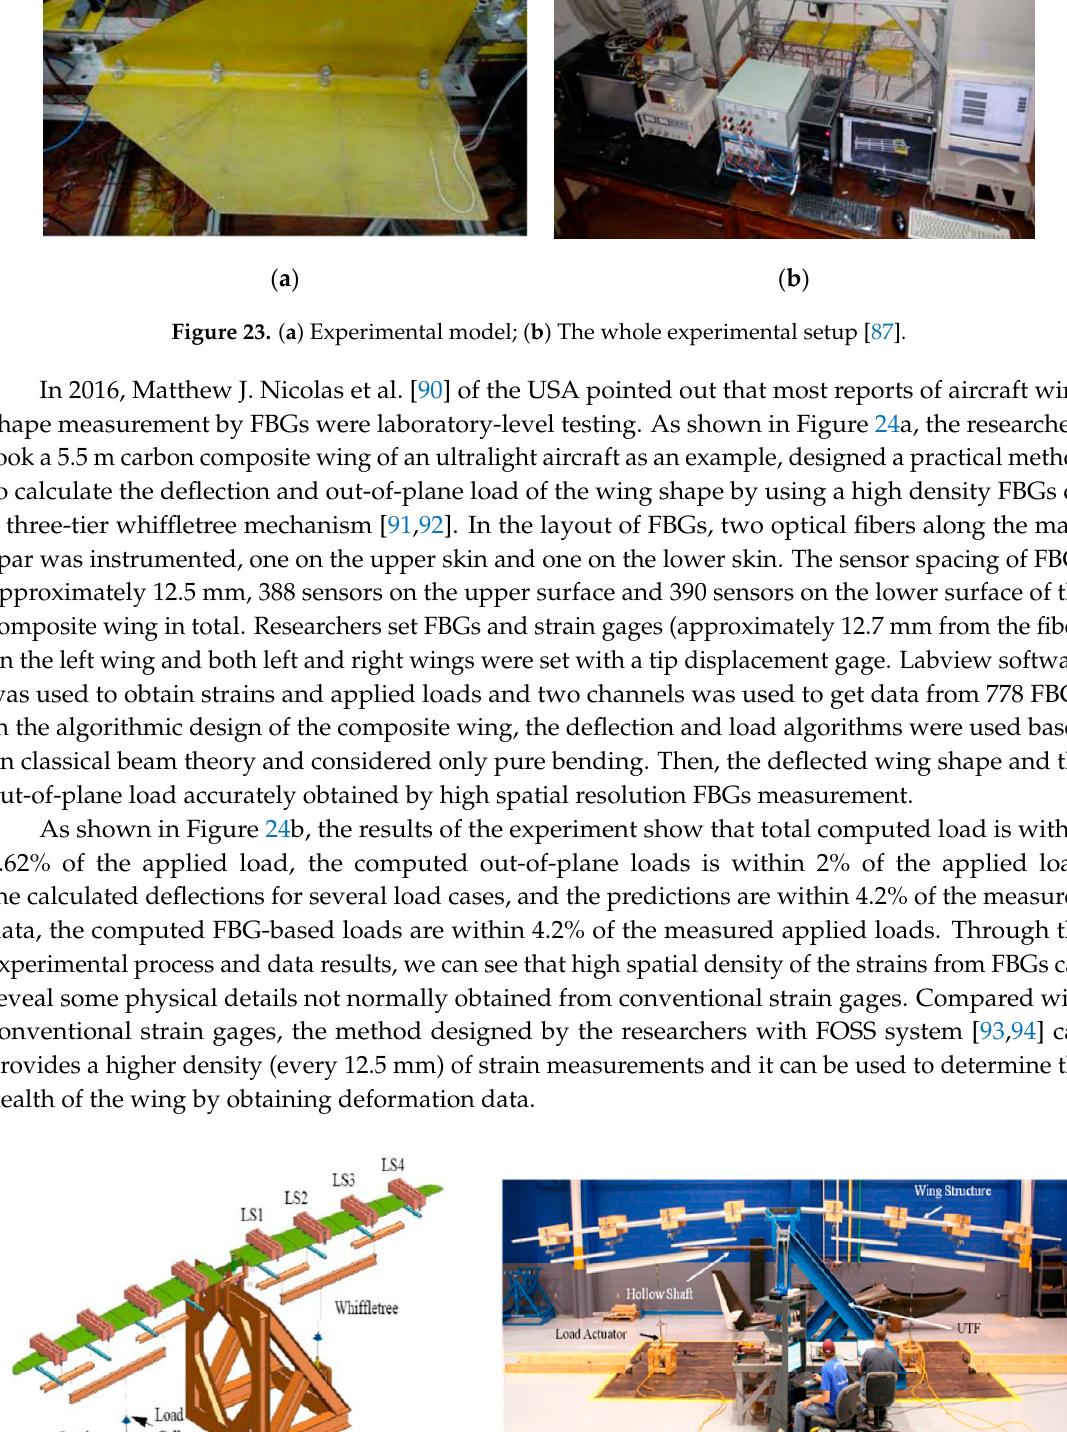
( b ) Figure 22. ( a ) Strain distributions measured by A-1; ( b ) Strain distributions measured by B-1 [86]. In 2012, in order to accurately calculate the deformations of the aircraft wing, Yi Jincong et al. [87] of Shanghai University proposed an implementation method of FBGs in the deformation detection of wing structure. Researchers used epoxy resin plate with a trapezoid form as a kind of aircraft wing model. The dimensions of the wing model is 225 mm × 160 mm × 380 mm × 195 mm as shown in Figure 23a and the thickness is 1 mm. The experimental setup consists of FBG demodulator, computer, packaged FBG sensor array and three-dimension reconstruction visualization system as shown in Figure 23b. By comparison with optical other algorithms [88,89], an algorithm based on FBGs for deformation reconstruction of an aircraft wing model was proposed by researchers. The algorithm uses the curvature information measured by FBGs to reconstruct the wing shape. Firstly, the space coordinate system of the experimental model is established, and the coordinate values of each point in each curve are calculated according to the curvature. Then the smooth interpolation method is used to fit and reconstruct multiple curves. Finally, the shape of the surface can be reconstructed accordingly. By this method, the steady-state deformation and dynamic vibration characteristics of real-time deformed structures are experimentally studied. Researchers gave various static deformation in manual way for the wing model and the experimental results show that the reconstructed shape based on the designed algorithm have a good realistic rendering reality and real time effect. The characteristic of in this case is that researchers used the simplified wing model with